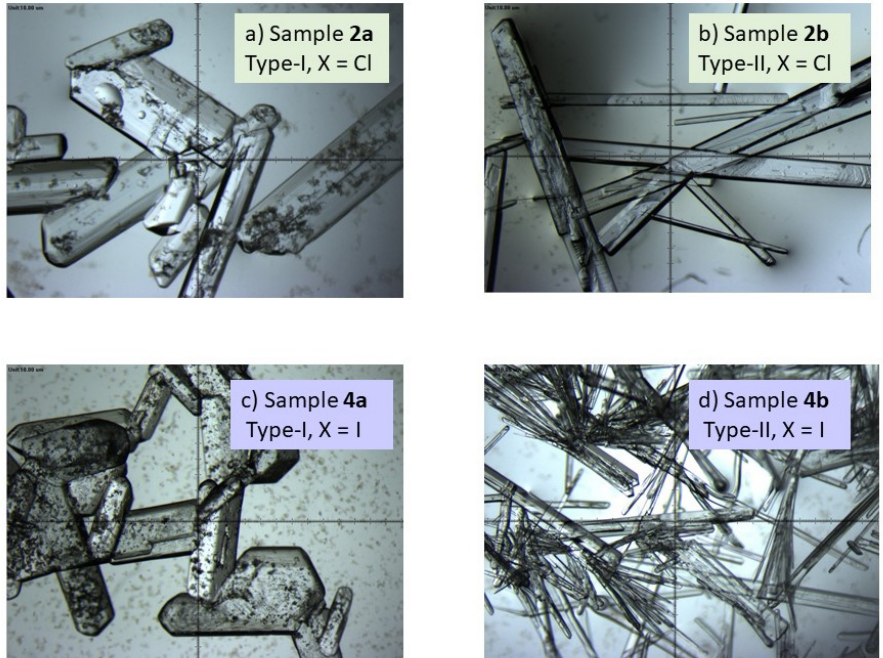
Figure 4. Powder X-ray diffractograms for 4a (from solution growth after hetero-seeding with 1 ) and 4b from LAG along with the coformers 11-Aza and 4-I-SalA.